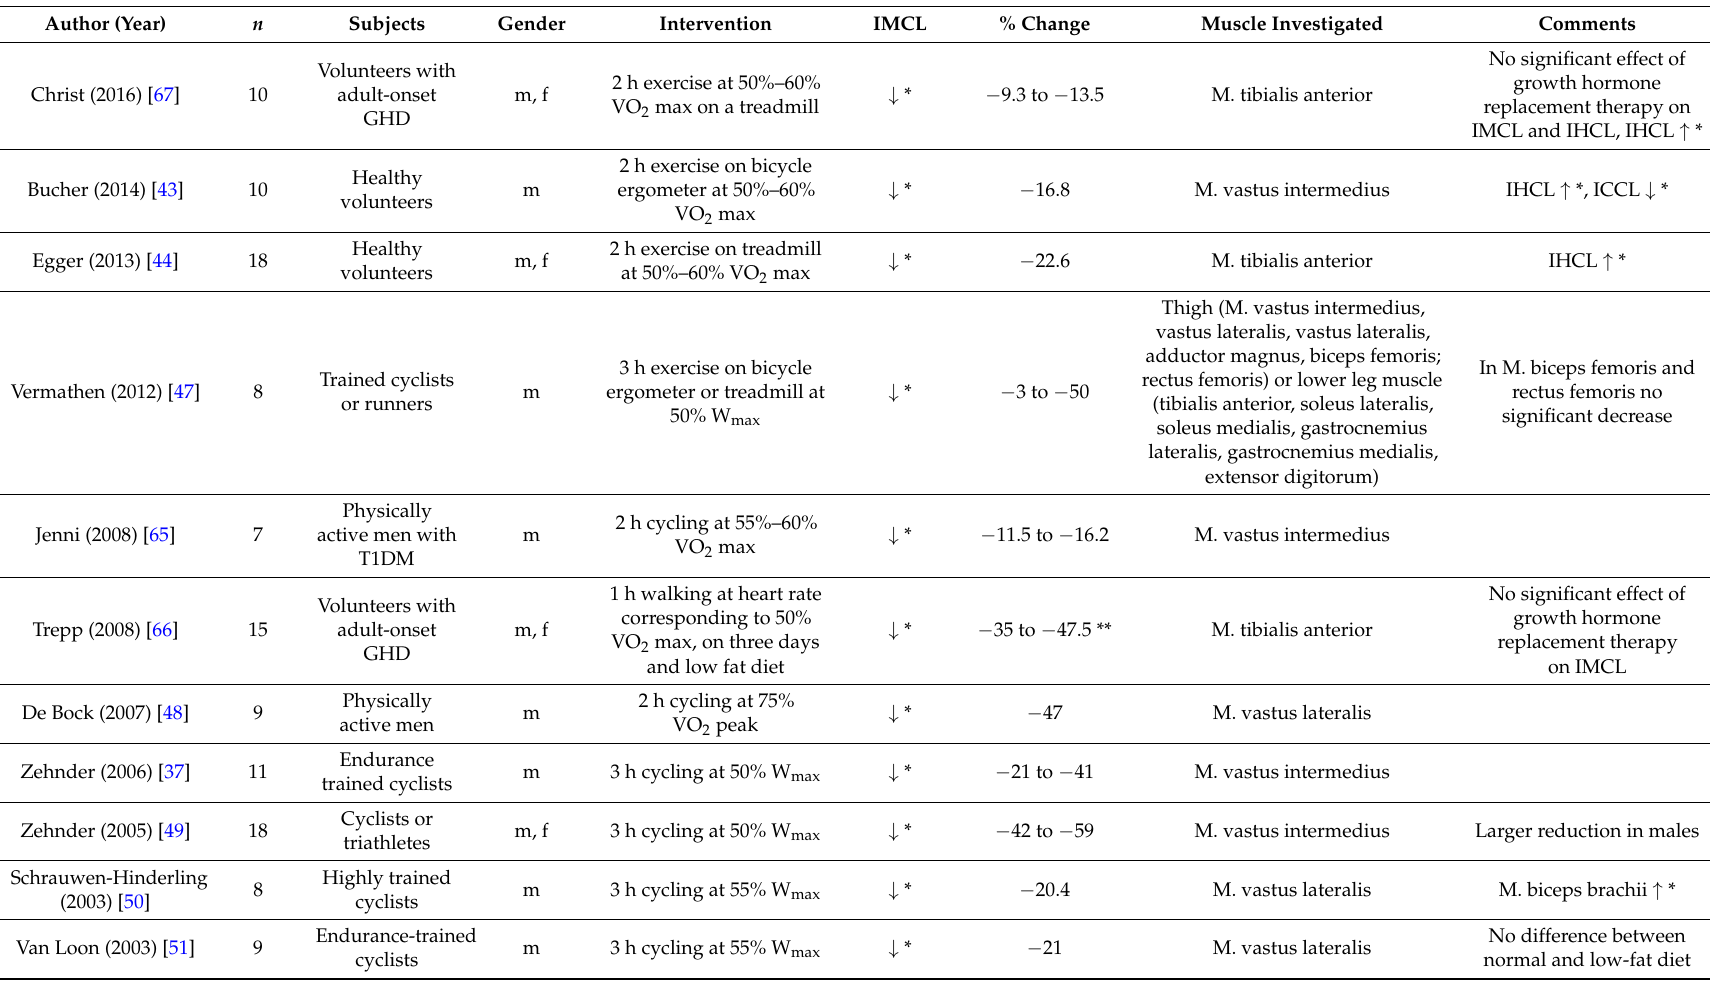
Table 1. Effect of short-term exercise on IMCL using 1